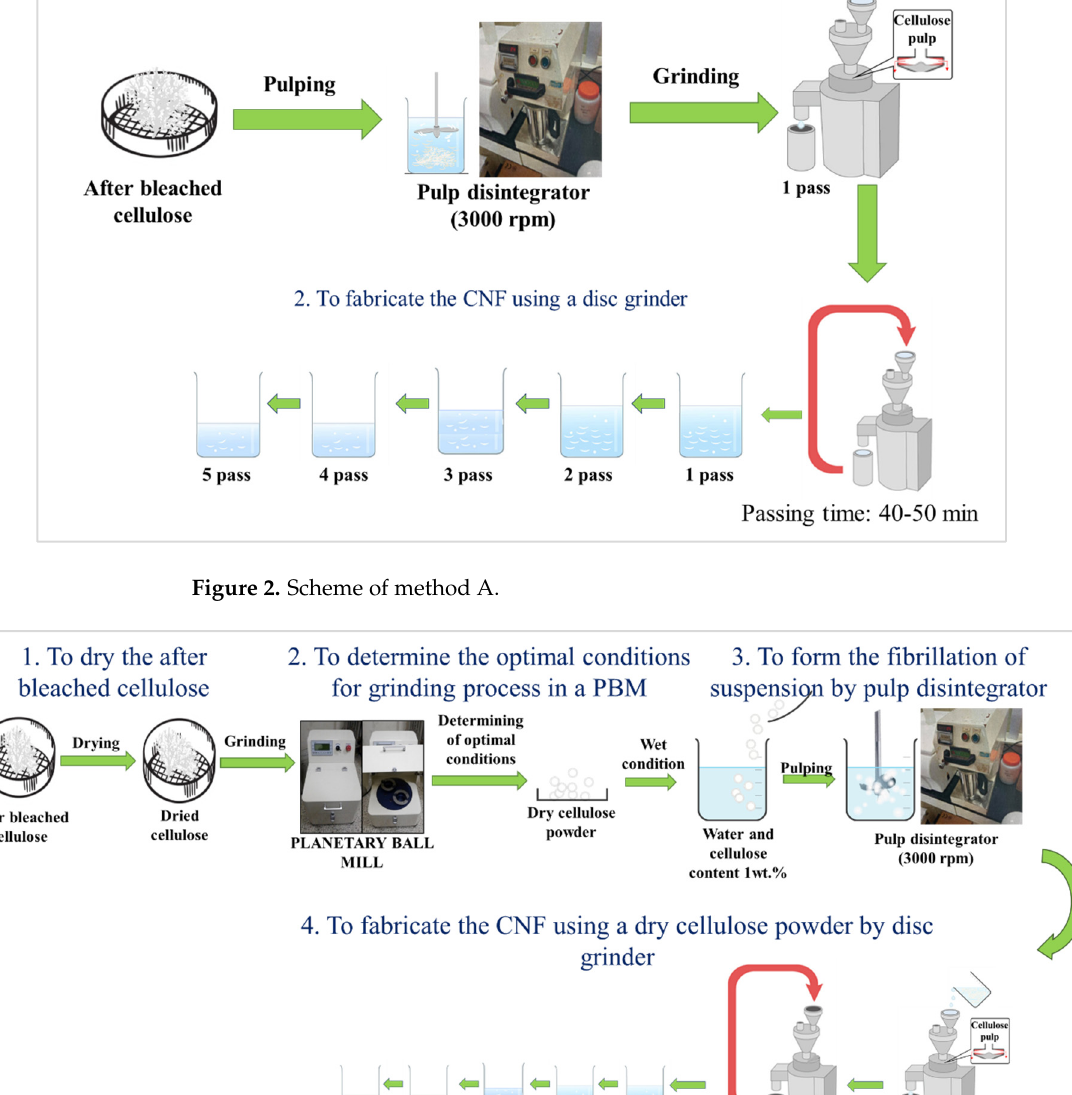
Table 1. Optimal experimental conditions for the PBM.